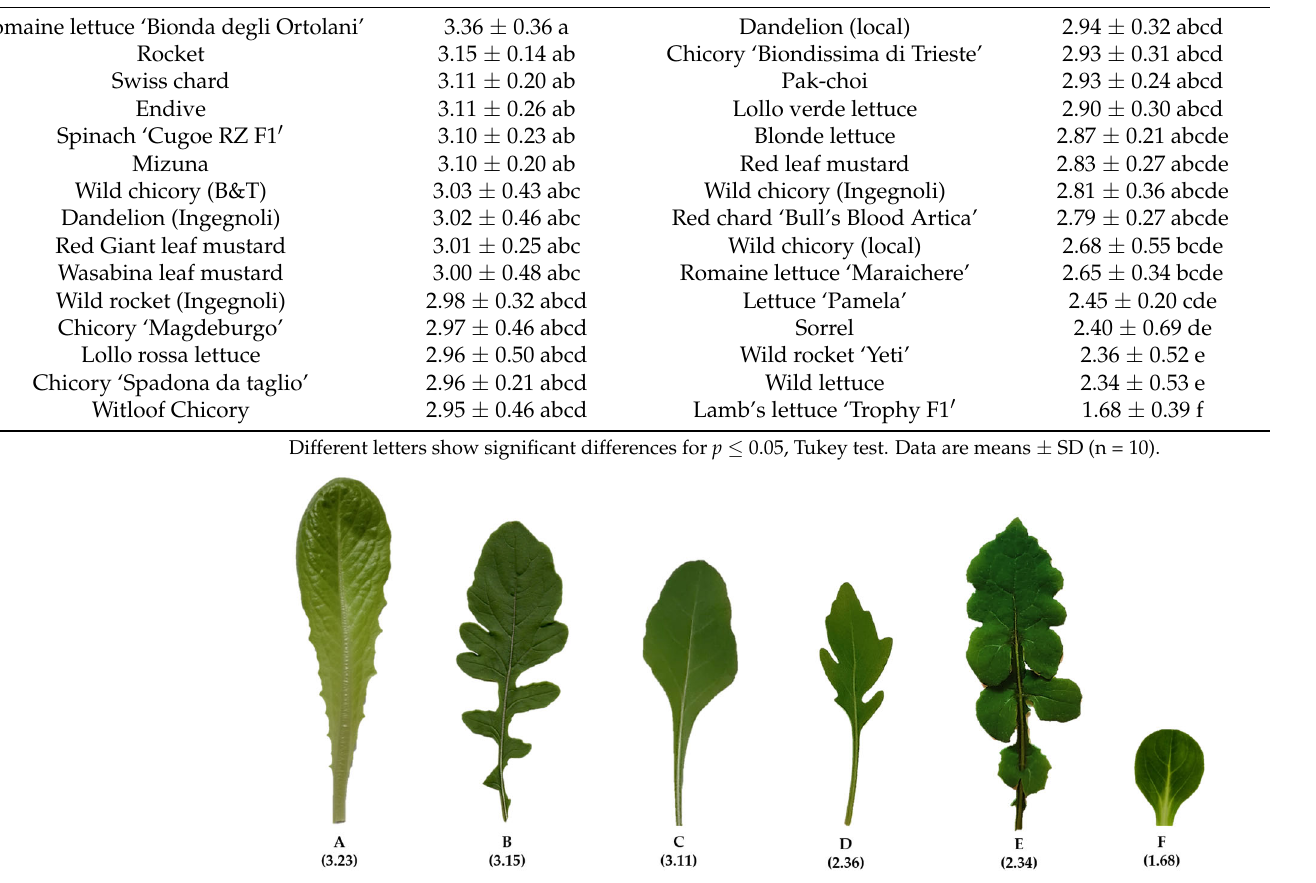
Figure 1. The six selected accessions: romaine lettuce ‘Bionda degli Ortolani’ ( A ), Swiss chard ( B ), and rocket ( C ) as the most susceptible to contamination, and wild rocket ‘Yeti’ ( D ), wild lettuce ( E ), and lamb’s lettuce ‘Trophy F1 ′ ( F ) as the least susceptible. Attachment values in brackets (log CFU/cm²).